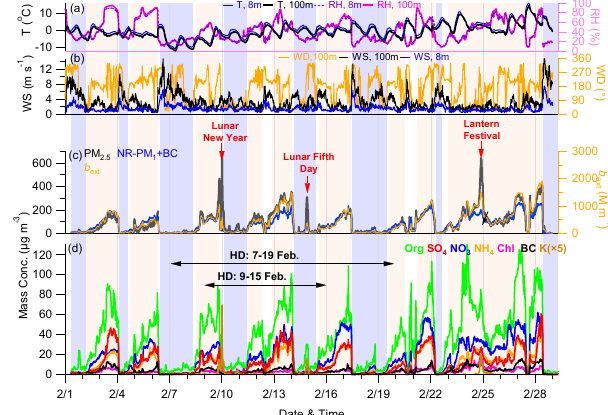
Figure 1. Time series of meteorological parameters: (a) relative hu- midity (RH) and temperature ( T ), (b) wind direction (WD) and wind speed (WS) at the height of 8 and 100m, mass concentra- tions of (c) PM 2 . 5 and NR-PM 1 +BC, and (d) submicron aerosol species. The extinction coefficient ( b ext ) at 630 nm is shown in (c) . Three events, i.e., LNY, LFD, and LF, with a significant influence of fireworks are marked in (c) . In addition, the classified clean peri- ods (CPs) and polluted events (PEs) are marked as shaded light-blue and pink areas,